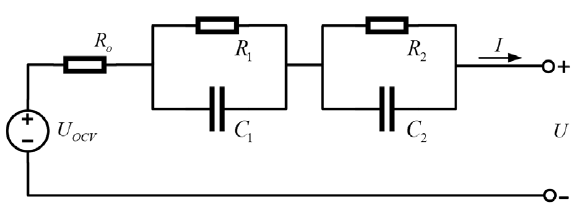
Figure 3. Equivalent circuit model of the ba tt ery cell.